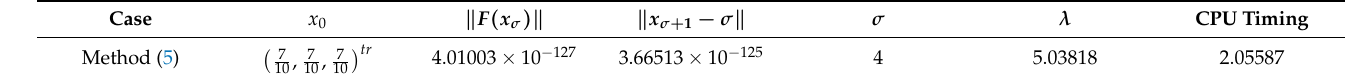
Table 3. Numerical results for Example 3.